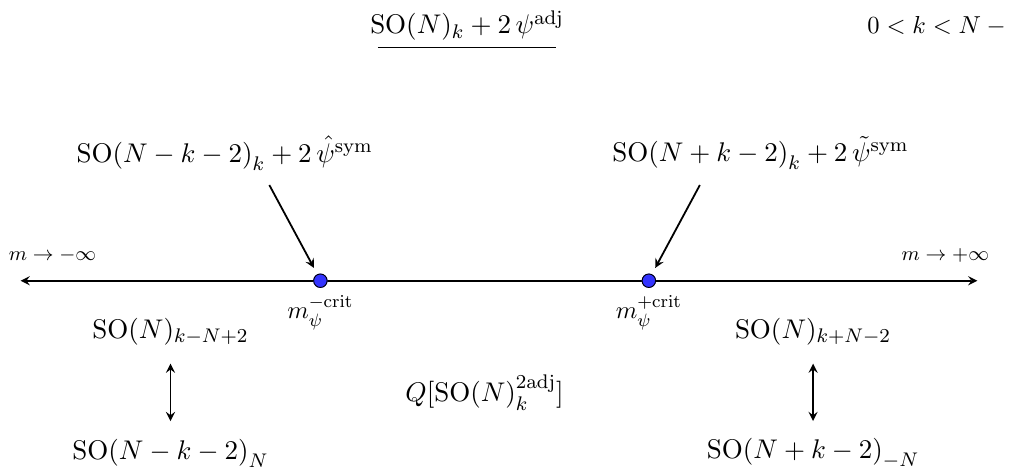
Figure 10 . Phase diagram of SO( N ) with two real adjoint fermions for 0 < k < N (cid:0) 2. The right dual description is always strongly coupled and left dual description is weakly coupled only when N= 2 (cid:20) k < N (cid:0)